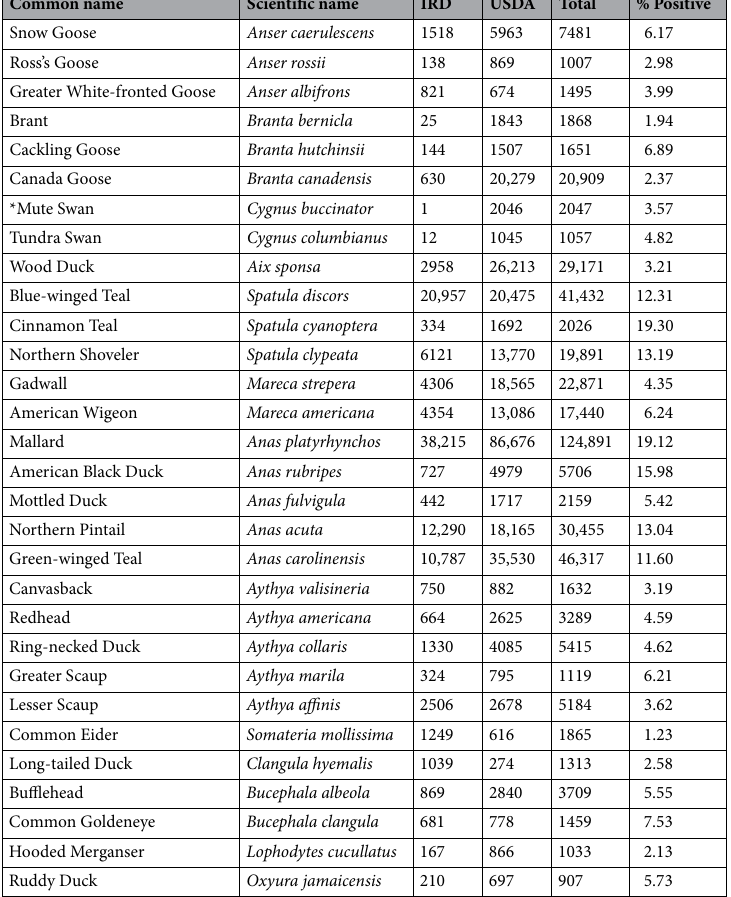
Table 1. Sample sizes for species included in the analysis from the IRD and USDA datasets and raw positivity rates not accounting for seasonal or spatial biases in sampling effort addressed in the provided predictions. *Mute Swan is non-native and